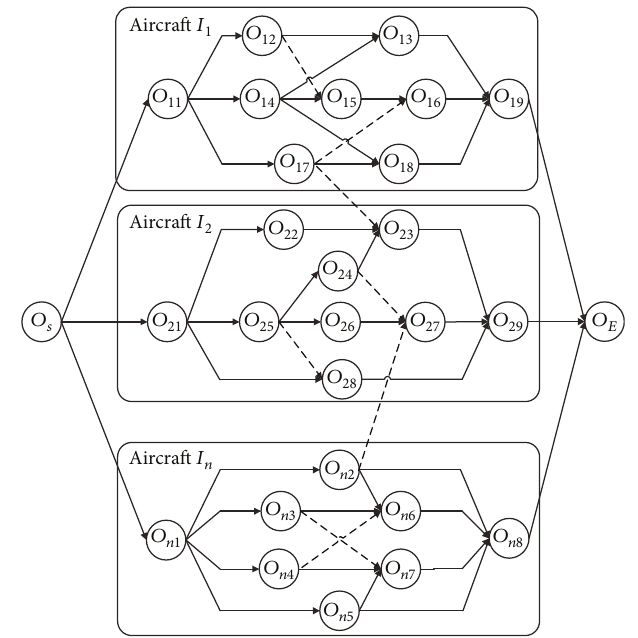
Figure 2: An example of the OONF network for